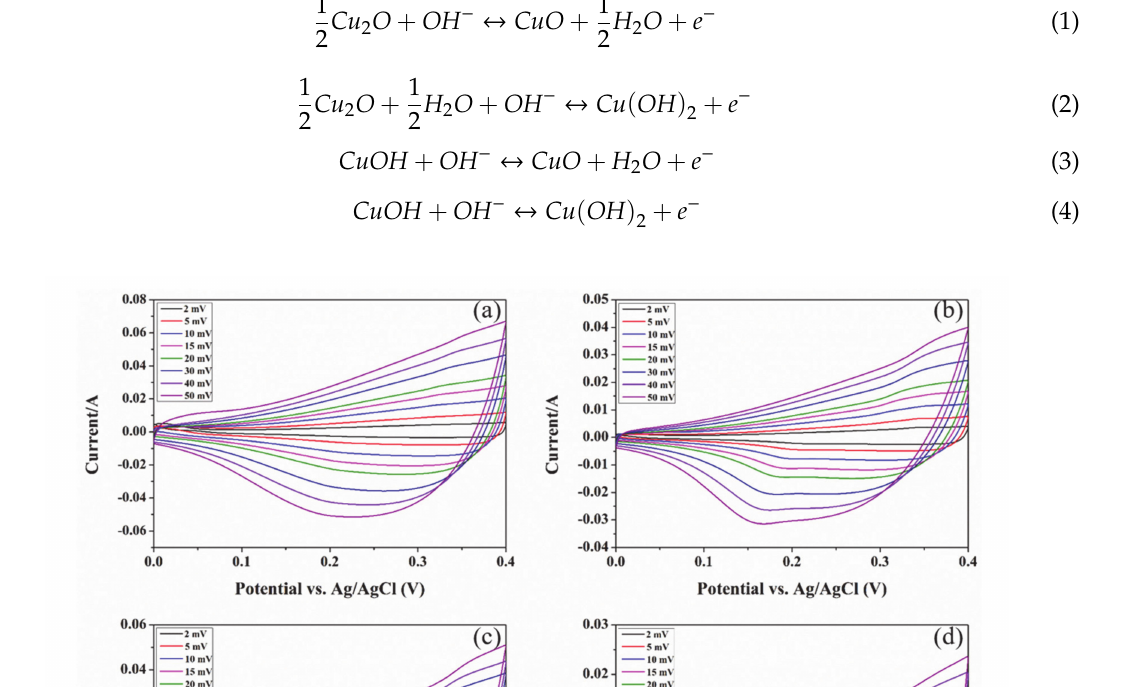
I (V) represents the response current, V (V) is the relative potential of the Ag / AgCl electrode, ν denotes the sweep speed, S (cm 2 ) is the e ff ective area of contact between electrode and electrolyte solution during testing, and ∆ V (V) is the value of the potential during the test. The specific capacitance of CuO / Cu foam electrode as shown in Table